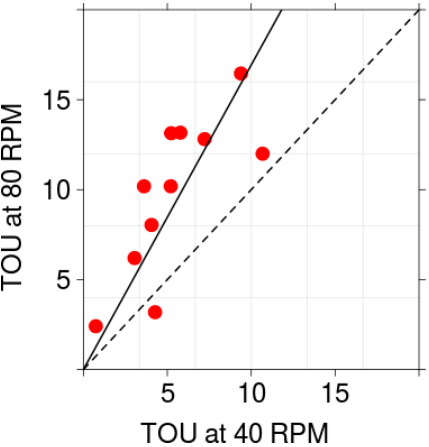
Figure 4. Total oxygen uptake rates measured in benthic incubation chambers at two different stirring rates (RPM: pounds per minute); dashed line: 1:1 line; solid line: linear regression; red symbols: SNS. All rates in mmol O 2 m − 2 d − 1 .